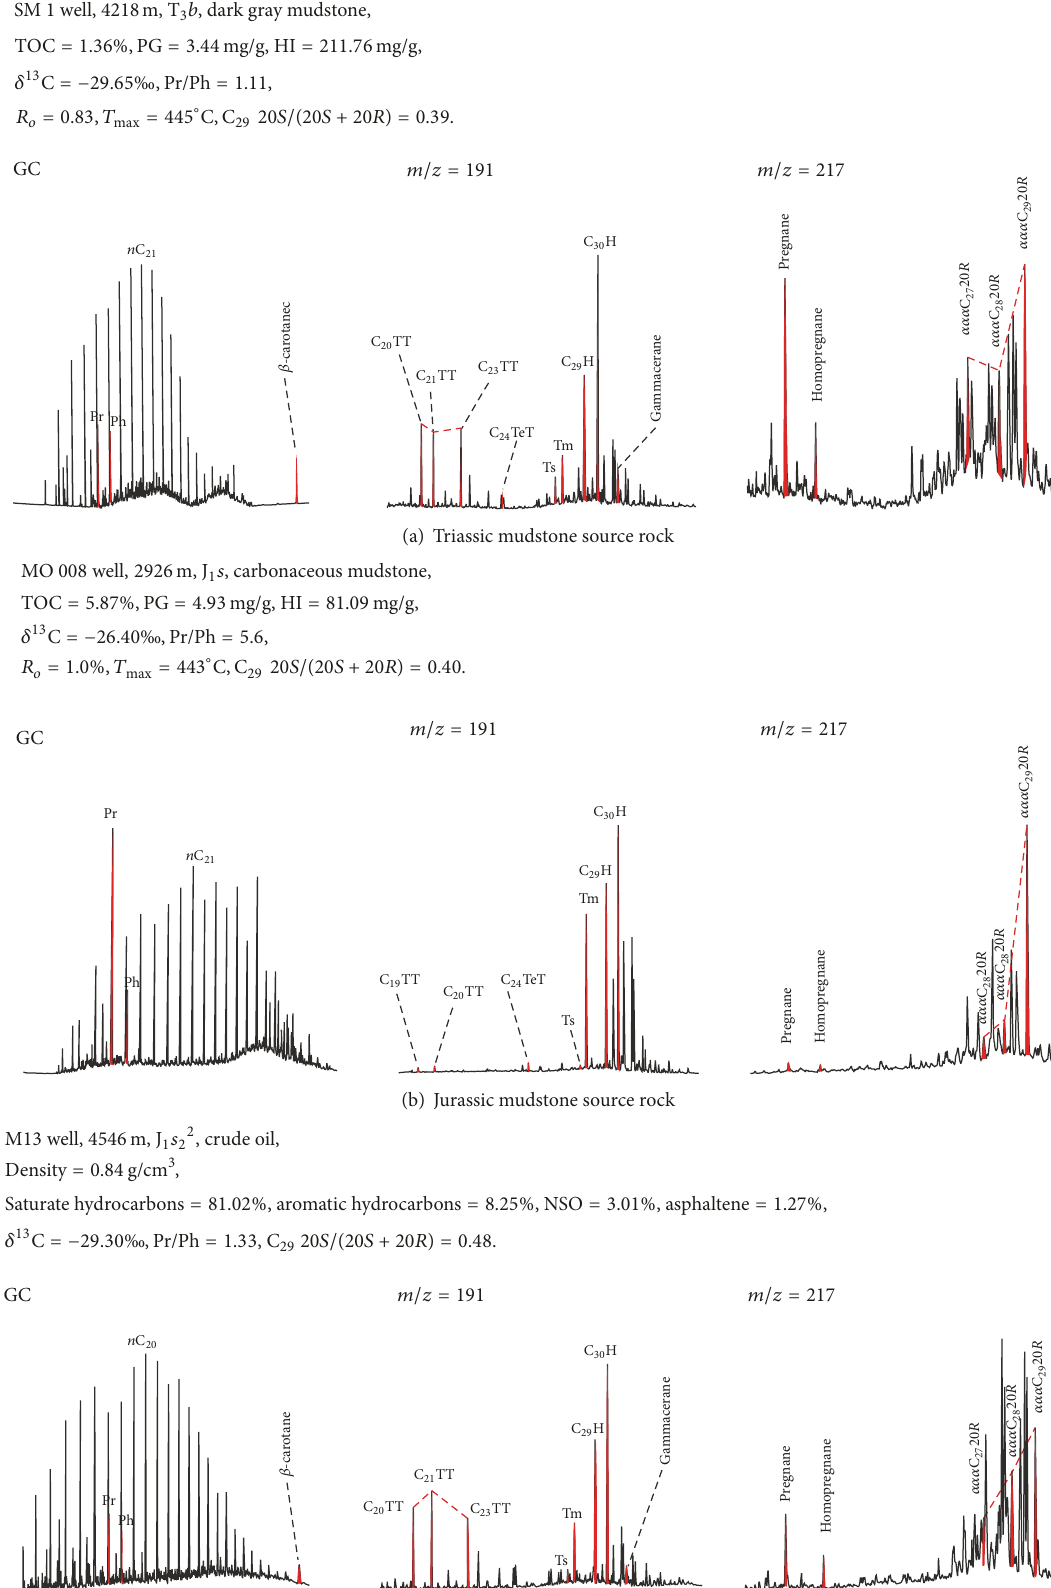
(c) 𝑃 2 𝑤 mudstone source